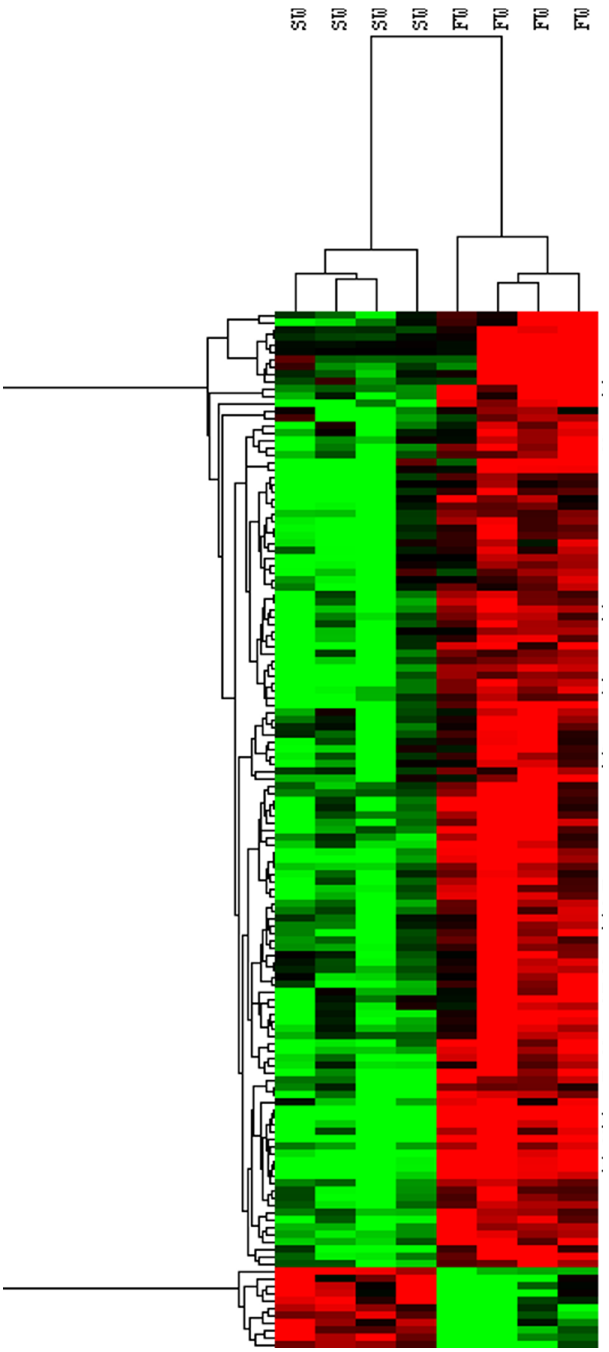
Fig 2. Hierarchical clustering analysis of gene differentially expressed between FW and SW ionocytes. Analysis was performed based on a log 2 -transformed ratio value of 138 genes differentially expressed. Row and columns represent genes and samples respectively. Expression levels of log 2 - transformed ratio are represented by a color tag: red and green for high and low levels of expression